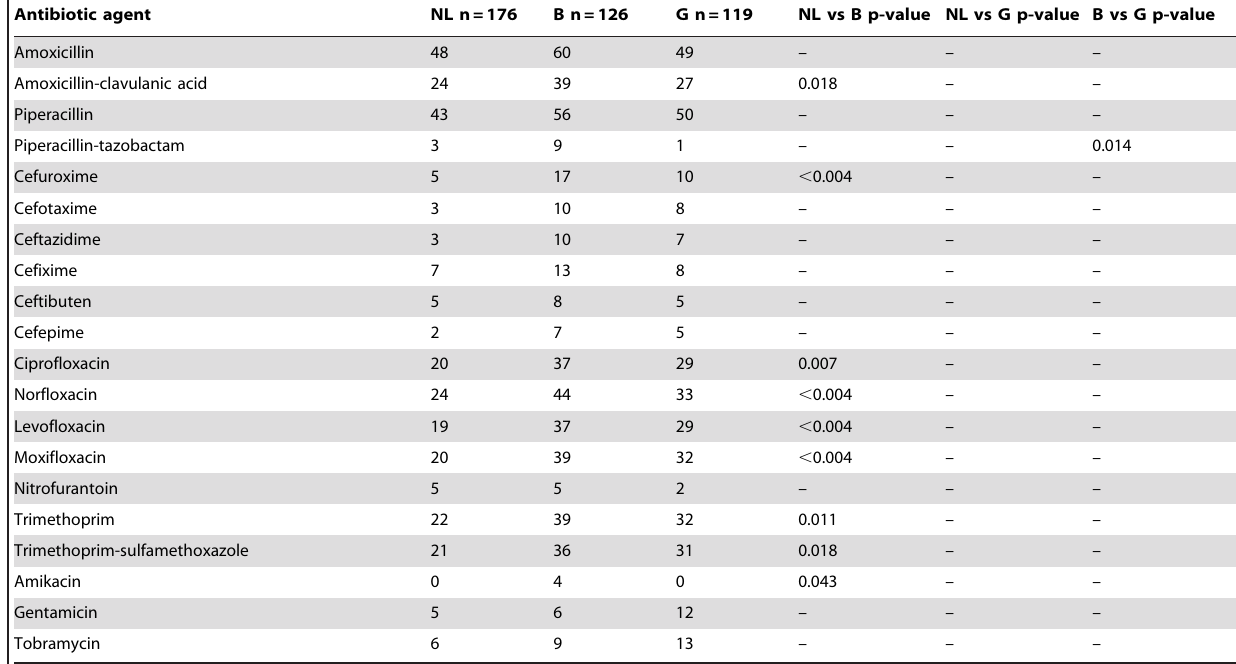
Antibiotic agent